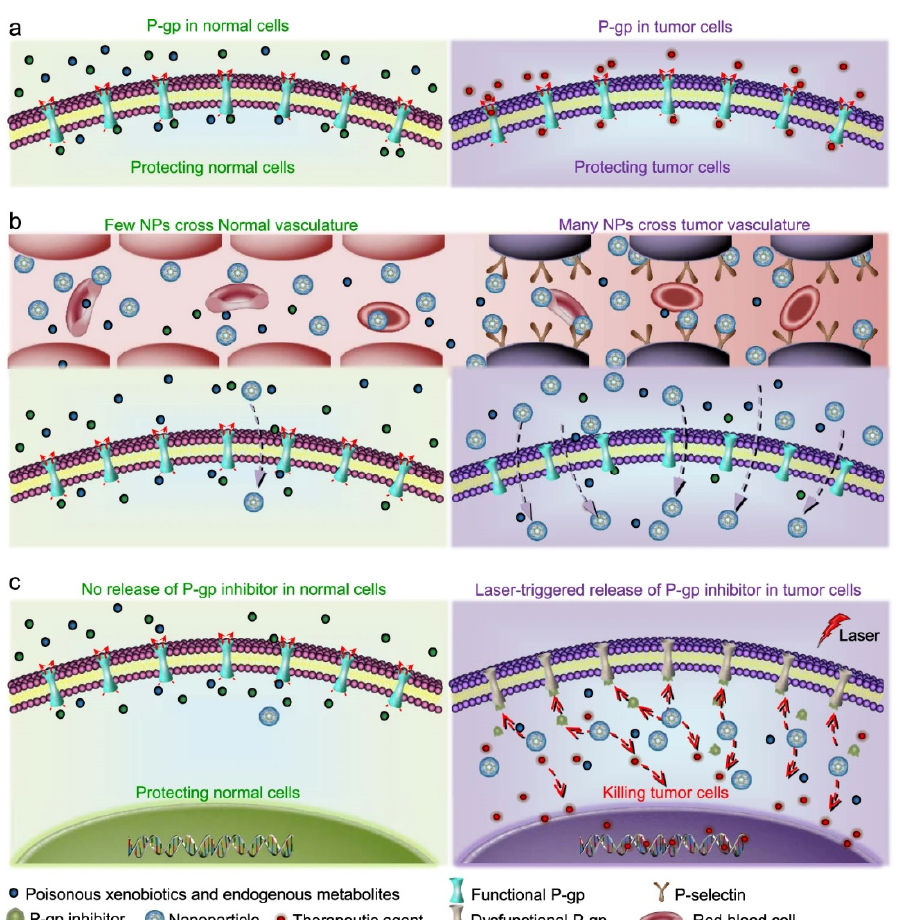
Figure 4. Schematic illustration of the strategy for targeting multi-drug resistant cancer cells and inhibiting the P-gp pump using CNOs. Reproduced from [163] under a Creative Commons license.